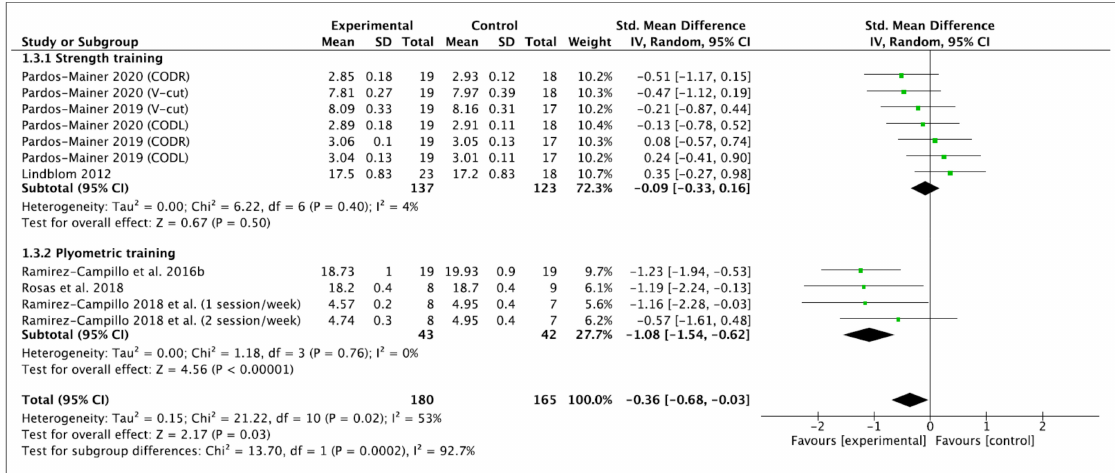
Figure 6. Forest plot of between-mode effect sizes with 95% confidence intervals (CIs) in the time of change of direction (s). IV: inverse variance method; SD: standard deviation; Std: standardized.